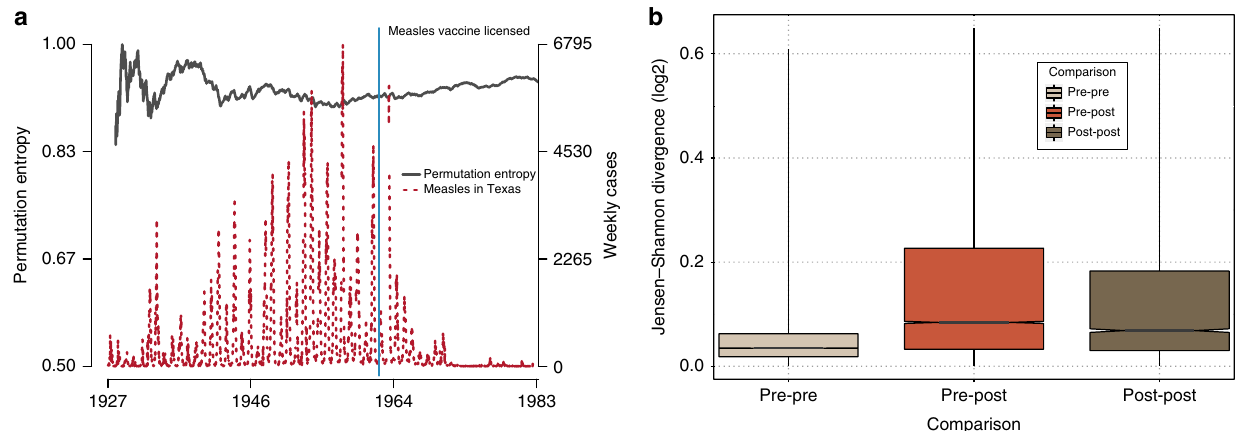
Fig. 4 Predictability shifts after the start of widespread measles vaccination. a Measles in Texas: permutation entropy shifts after the start of widespread vaccination. A rolling window estimate of the permutation entropy for weekly measles cases reported to the CDC from the state of Texas between 1927 and 1983 (red dashed line). The vertical blue line indicates when the fi rst measles vaccine was licensed for use in the United States. Shortly after the vaccine was introduced the permutation entropy increased signi fi cantly, which is expected after a system experiences a change to its model structure, in this case vaccination. b Permutation entropy detects changing model structure across all states in the United States. The box-plots aggregate the Jensen – Shannon divergences between pairs of windows that are both in the pre-vaccine era (light brown), have one window in the pre- and one in the post-vaccine era (red) and both in the post-vaccine era (dark drown). The Jensen – Shannon divergence of the symbol frequency distribution was calculated between all pairs of rolling 1-year (52 week) windows for measles time series across the United States. The average divergence between symbol distributions was higher between windows in the pre- and post-vaccine era, as compared to windows that were either both in the pre- or both in the post- vaccine era (determined by permutation test and by an analysis of variance that also included state-level differences in the Jensen – Shannon divergence and a Tukey honest signi fi cant differences post hoc test, which contained a correction for multiple comparisons). The solid line represents the median, boxes enclose the 25th to 75th percentiles of the distributions, and whiskers cover the entire distribution